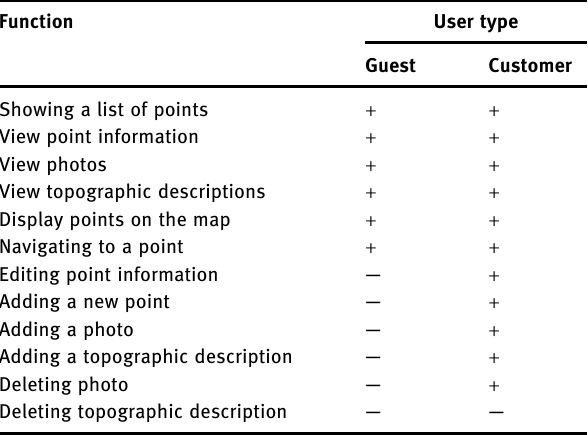
Table 2: Functions available to the user as guest and customer